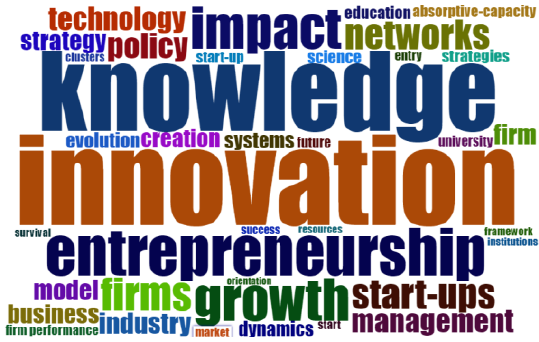
Figure 6. Word cloud